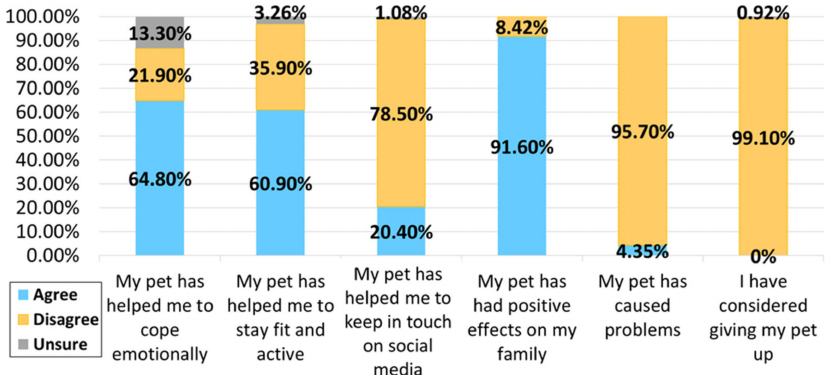
Figure 3. Perceptions of pet-owning PwMS during COVID-19.